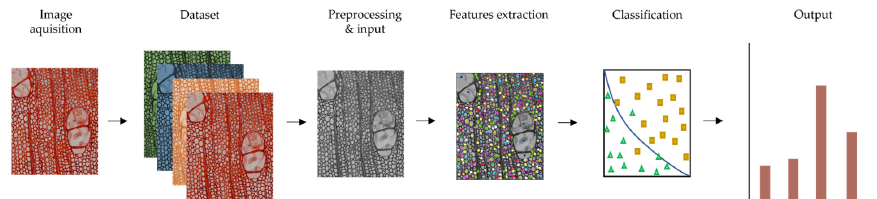
Figure 1. General scheme of machine learning method for image classification (based on